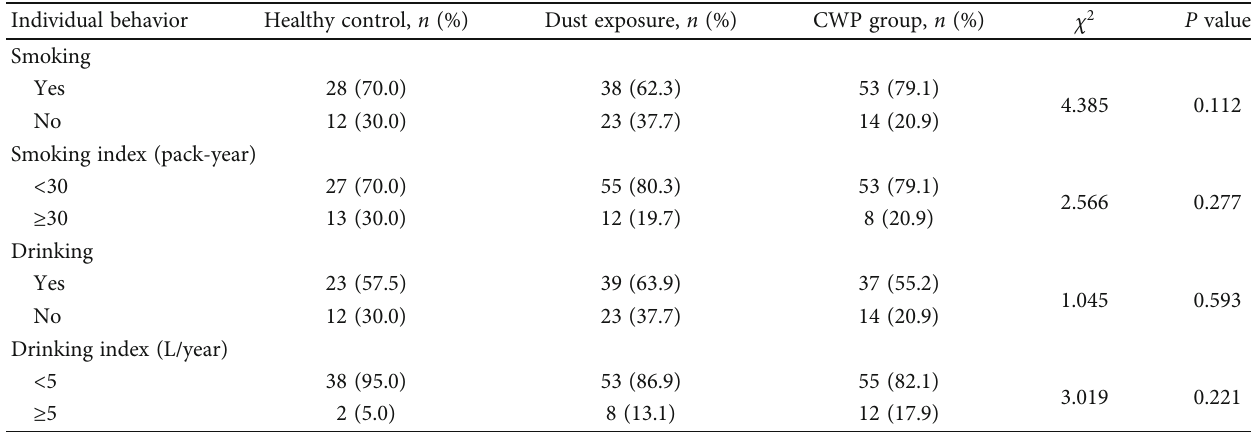
Table 3: Characteristic analysis of individual behavior factors of coal workers.